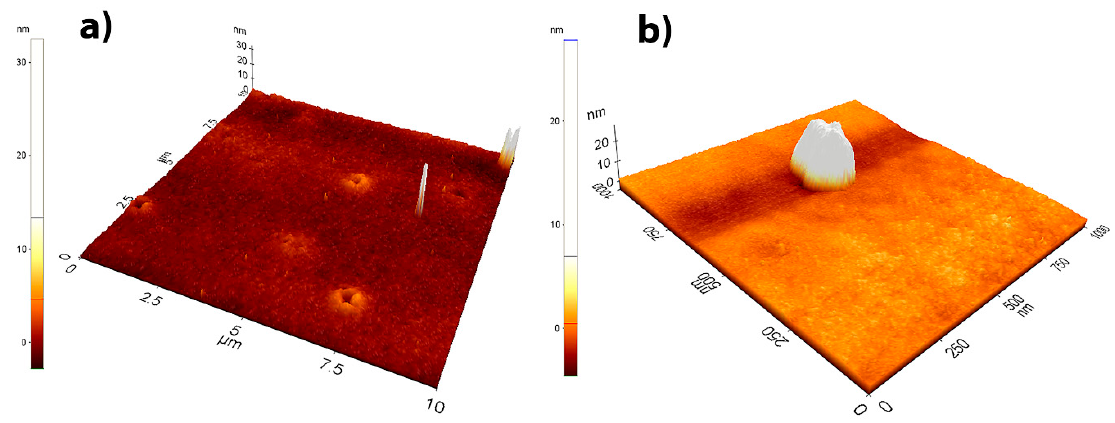
Figure 1. Atomic Force Microscopy (AFM) profile of sol-gel-obtained porous SiO 2 film on Si substrate (sample P1): ( a ) Surface morphology of the SiO 2 layer with visible open pores, ( b ) magnification of the surface of the oxide layer, illustrating the uniformity of the SiO 2 film (white spot is a